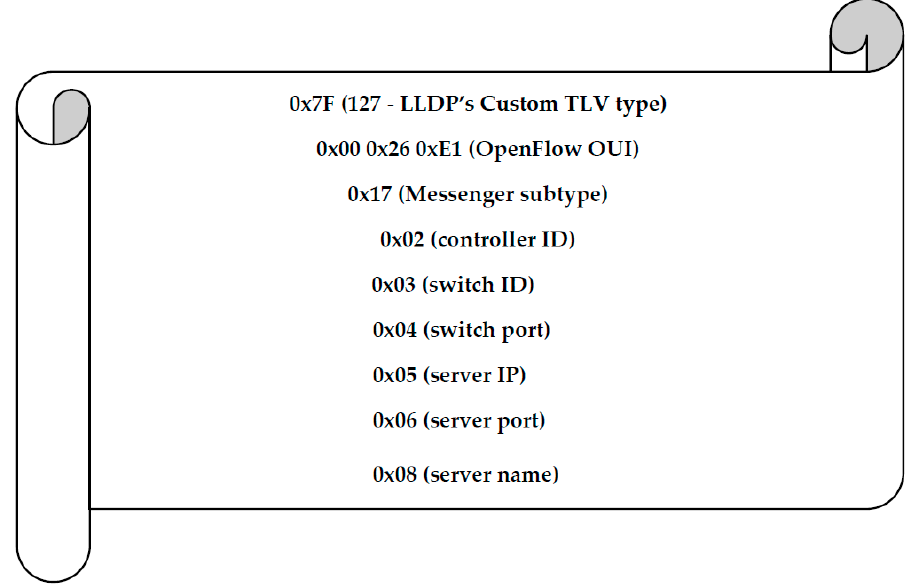
Figure 3. The discovery message. LLDP: Link Layer Discovery Protocol; OUI: Organizationally Unique Identifier.